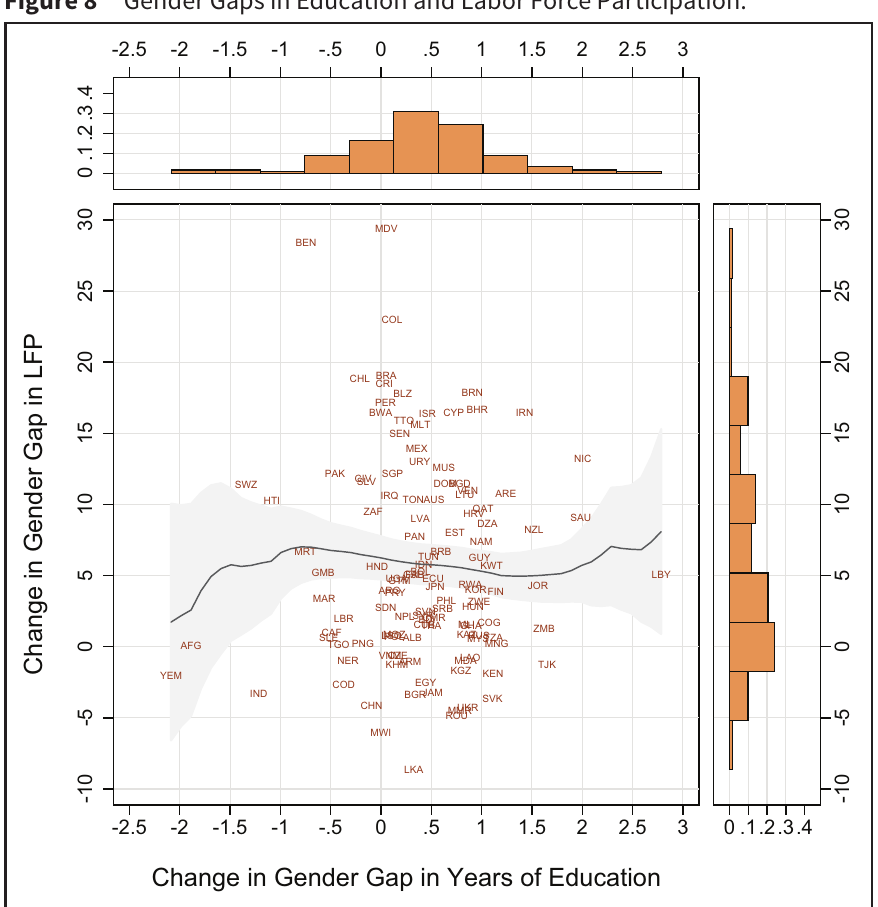
Figure 8 Gender Gaps in Education and Labor Force